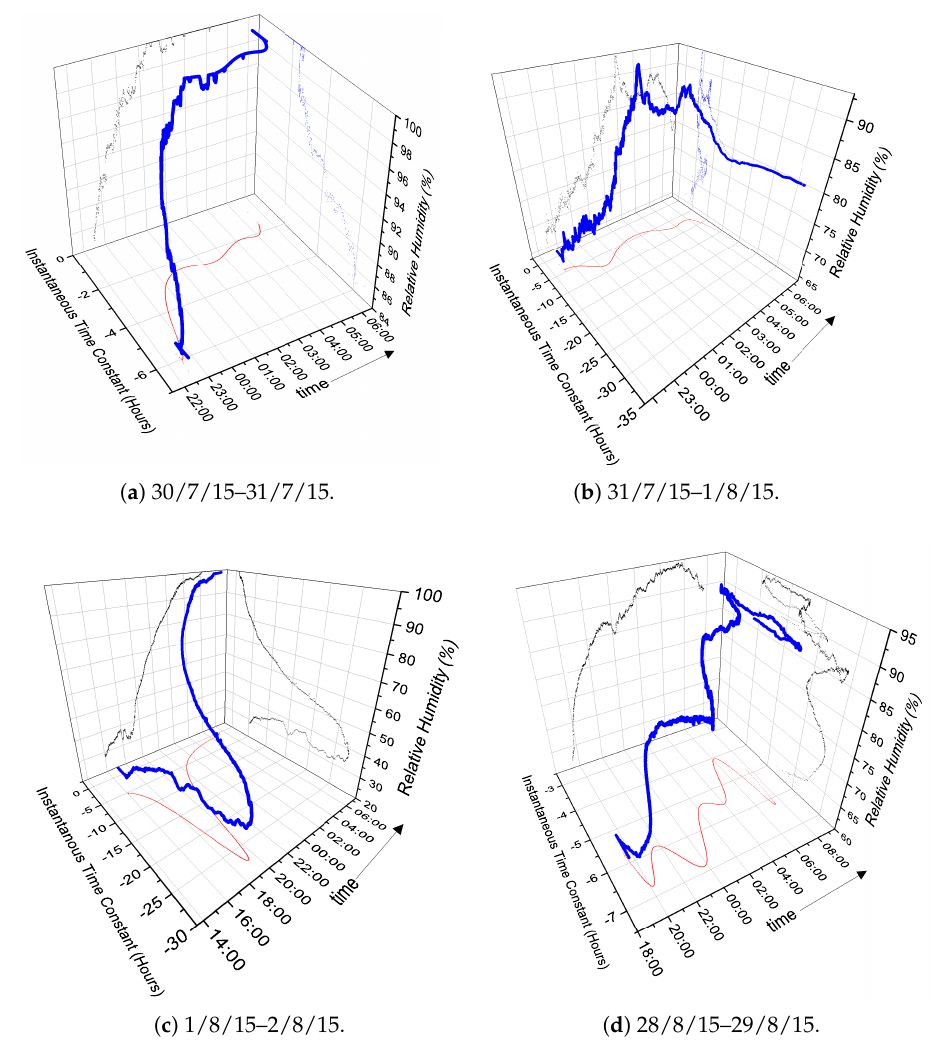
Figure 13. Relative Humidity plotted against instantaneous time constant and time for the last 4 overnight